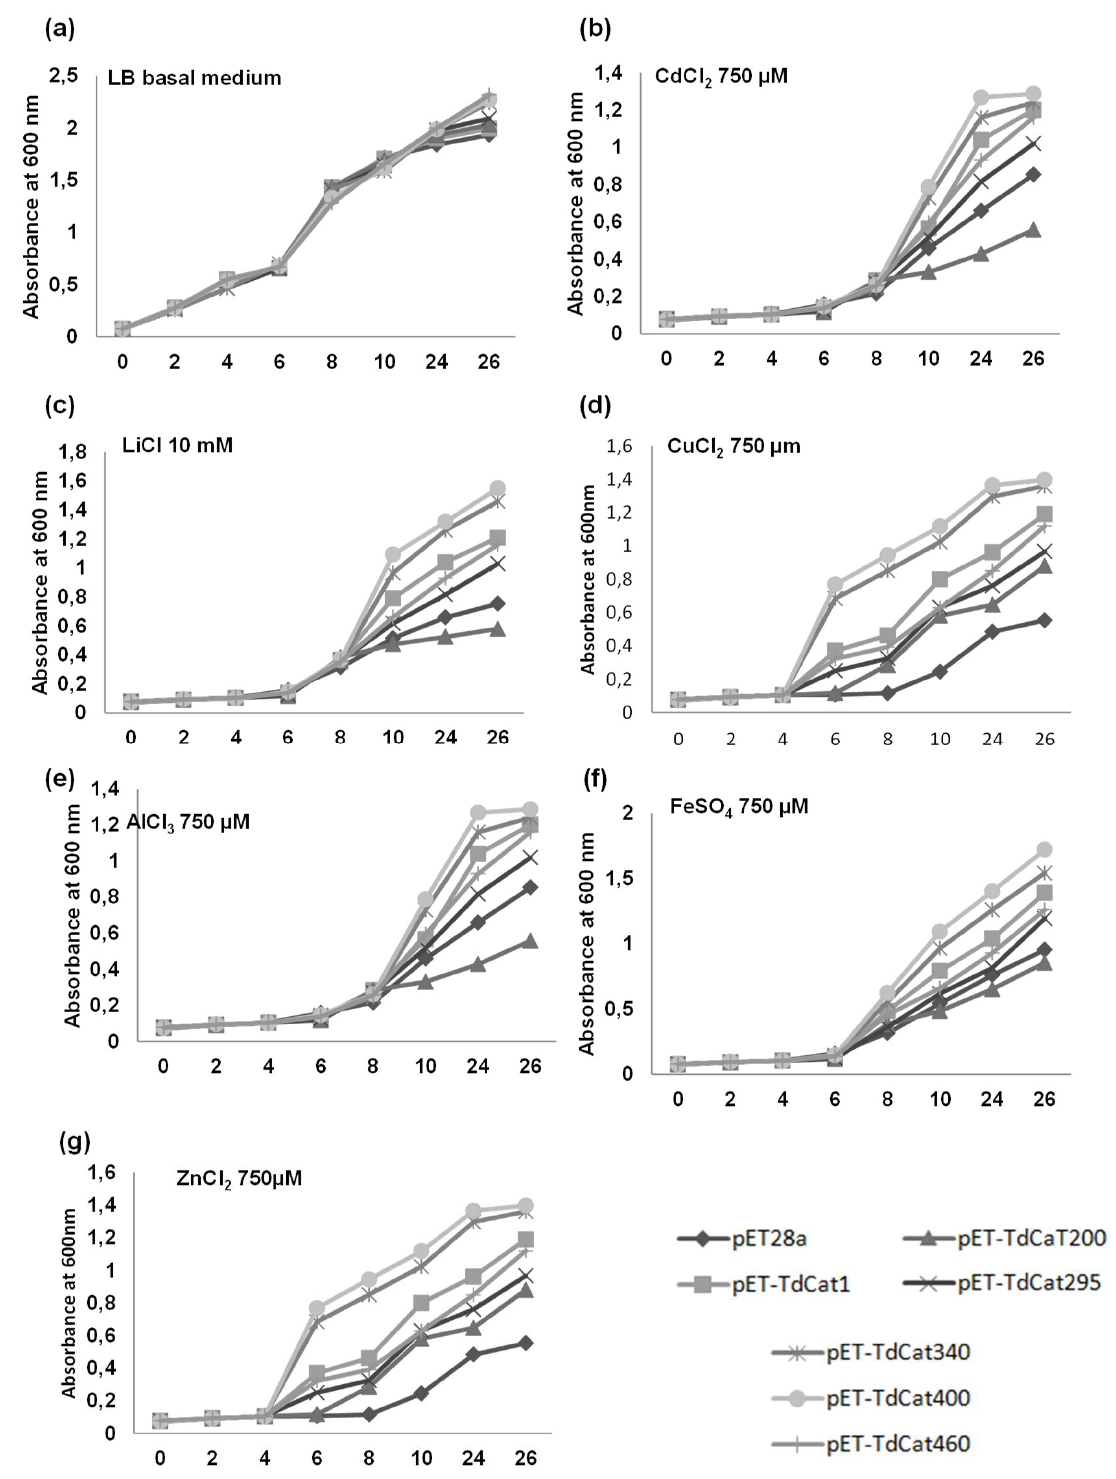
Figure 8. Behavior of TdCAT1 and derivative-forms-transformed bacteria in liquid LB medium in normal conditions or in the presence of metallic stress. E. coli cells transformed with the empty vector (pET28a) or with the recombinant vectors (pET28a + TdCAT1 or its derivatives) were grown for 24 h under normal growth conditions (LB medium, ( a )) or after the addition of 750 µL of CdCl 2 ( b ), 10 mM LiCl ( c ), 750 µL CuCl 2 ( d ), 750 µL AlCl 3 ( e ), 750 µL FeSO 4 ( f ), or 750 µL ZnCl 2 ( g ). Data are means ± SE of three biological replicates.